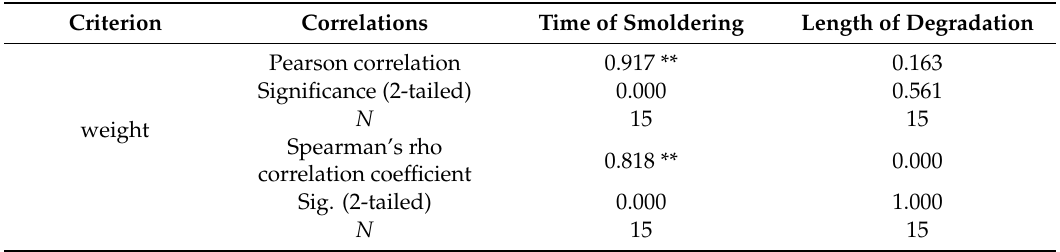
Table 7. Correlations between “weight” and “time of smoldering” or “weight” and “length of